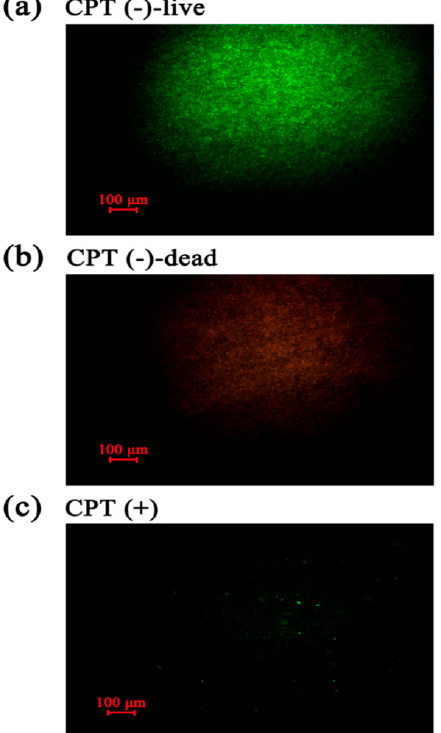
Figure 5. Live/dead cell staining analysis of strain RS-2 cells exposed to 0.5 mg/mL CPT for 8 h. Staining were carried out using live/dead BacLight bacterial viability kit (Invitrogen, Carlsbad, CA, USA), and visualized by fluorescence microscopy. Green fluorescence is representative of live bacteria with intact membranes, while red fluorescence is representative of dead bacteria. ( a ): Live bacteria in negative control; ( b ) Dead bacteria in negative control; ( c ) Bacteria in CPT treatment.